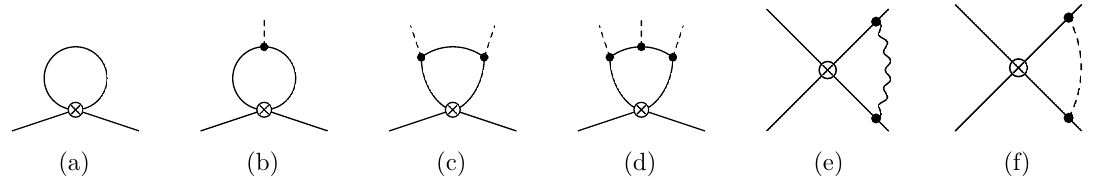
Figure 4. Supertrace topologies needed to evaluate the one-loop evanescent contributions to the Warsaw matching. The crossed circles denote evanescent operator interactions whereas black dots denote the SM ones. Solid, wavy, and dashed lines represent fermionic, gauge, and scalar fields,